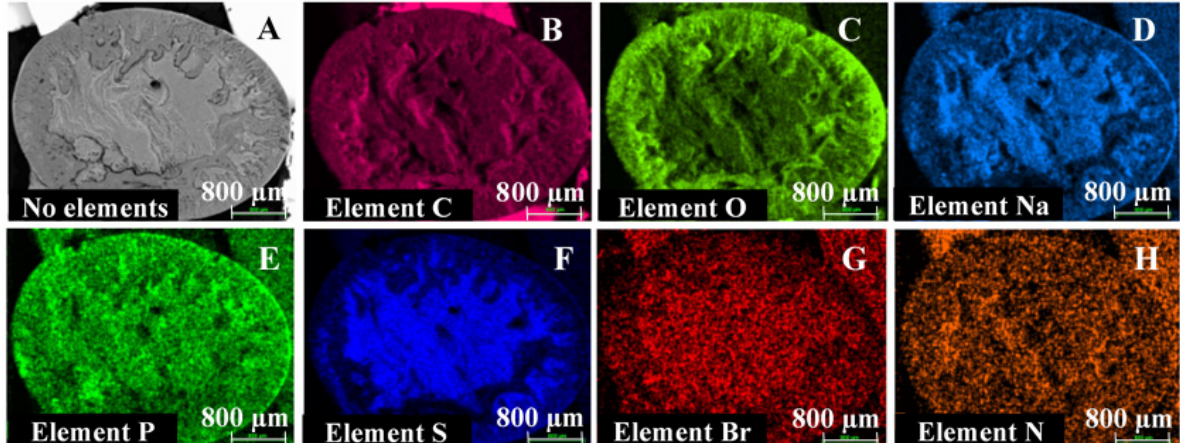
Figure 5. Scanning electron microscopy (SEM) image and energy-dispersive X-ray spectroscopy (EDX) elemental maps of spherical in situ forming gels prepared for formulation 1 containing 200 mg eq./g bedaquiline fumarate salt in PLGA5050A/NMP 20/80% ( w / w ). SEM image (Panel ( A )), EDX maps for carbon coloured pink (Panel ( B )), oxygen coloured green (Panel ( C )), sodium coloured blue (Panel ( D )), phosphor coloured green (Panel ( E ), sulphur coloured blue (Panel ( F )), bromine coloured red (Panel ( G )), and nitrogen coloured orange (Panel ( H )).